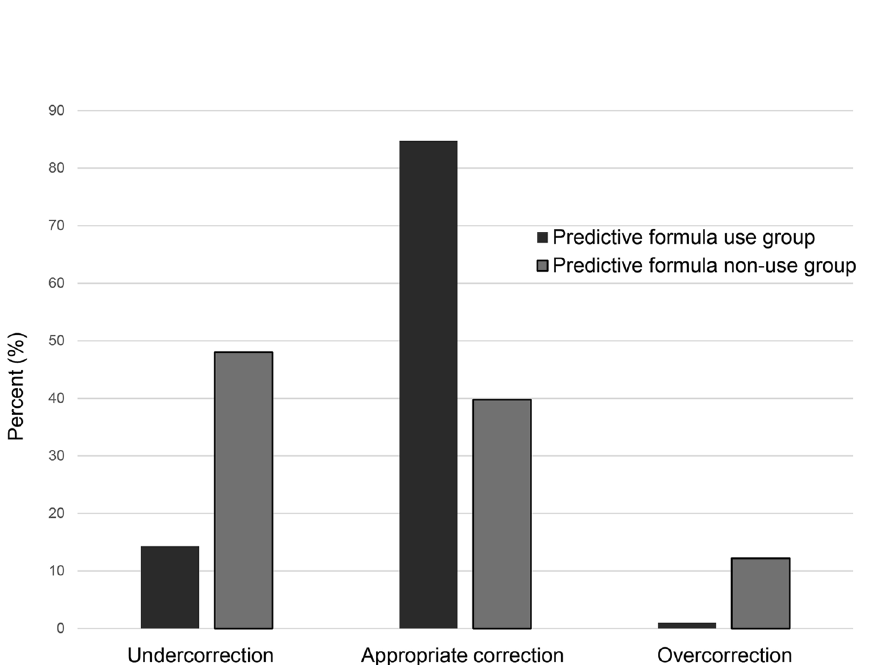
Figure 2. Percentage of patients with undercorrection, appropriate correction, or overcorrection with an initial serum sodium concentration ≤ 120 mEq/L according to the use or non-use of the prediction formula derived from the Edelman